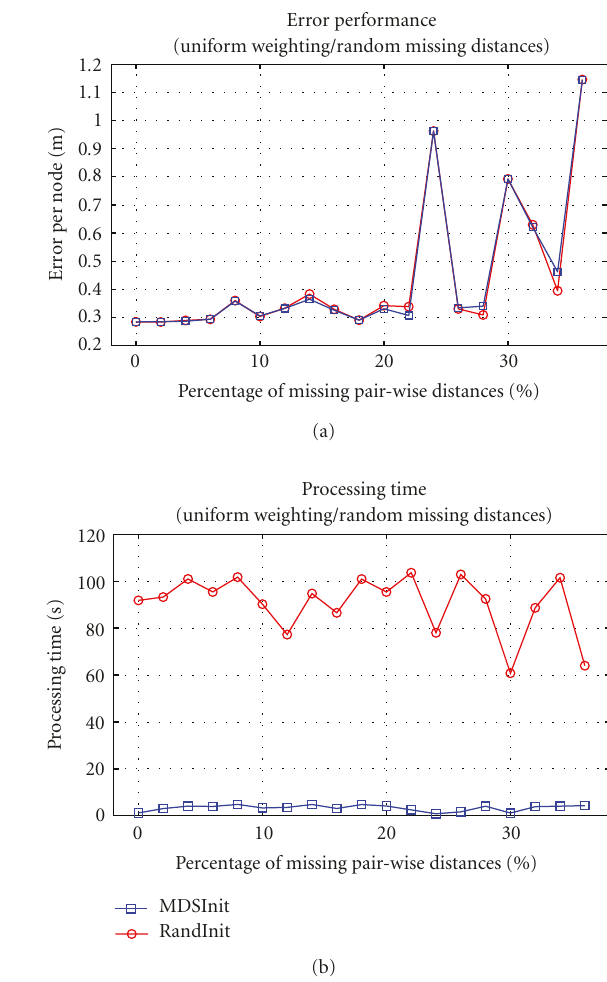
Figure 14: (a) Error performance; (b) processing time versus percentage of missing pairwise distances with uniform weighting and largest distances missing.